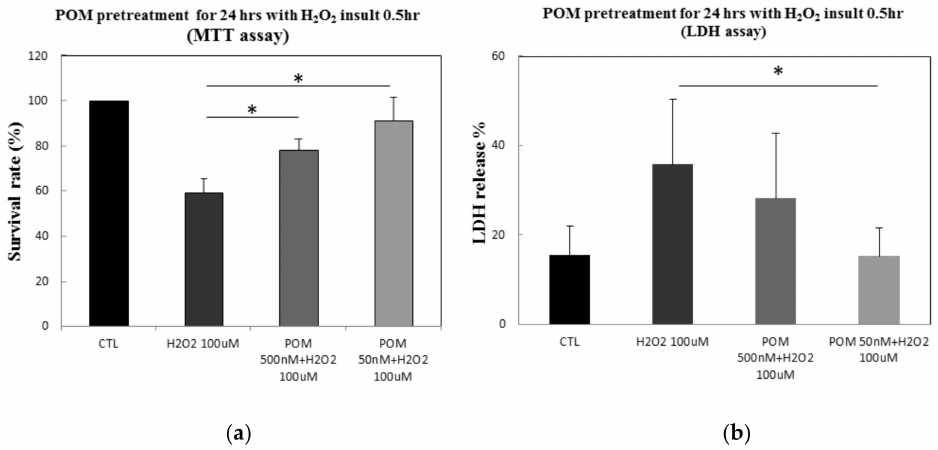
Figure 1. Effects of pomalidomide (POM) on H 2 O 2 -induced cellular death and cytotoxicity. ( a ) The MTT cell viability assay. The percentage of cell death was quantified by normalization of all values to the control (CTL) group (=100%). ( b ) The lactate dehydrogenase (LDH) release assay. Data are indicated as the percentage of LDH release of the injury group (H 2 O 2 -induced group). Compared to the control group, H 2 O 2 alone (100 µ M) induced a significant reduction in survival (MTT assay, p ≤ 0.05) and rise in LDH levels ( p ≤ 0.05). Both were significantly mitigated by POM (* p < 0.05 versus 100 µ M H 2 O 2 alone challenged group). Bars represent mean values ± standard error of the mean ( n =